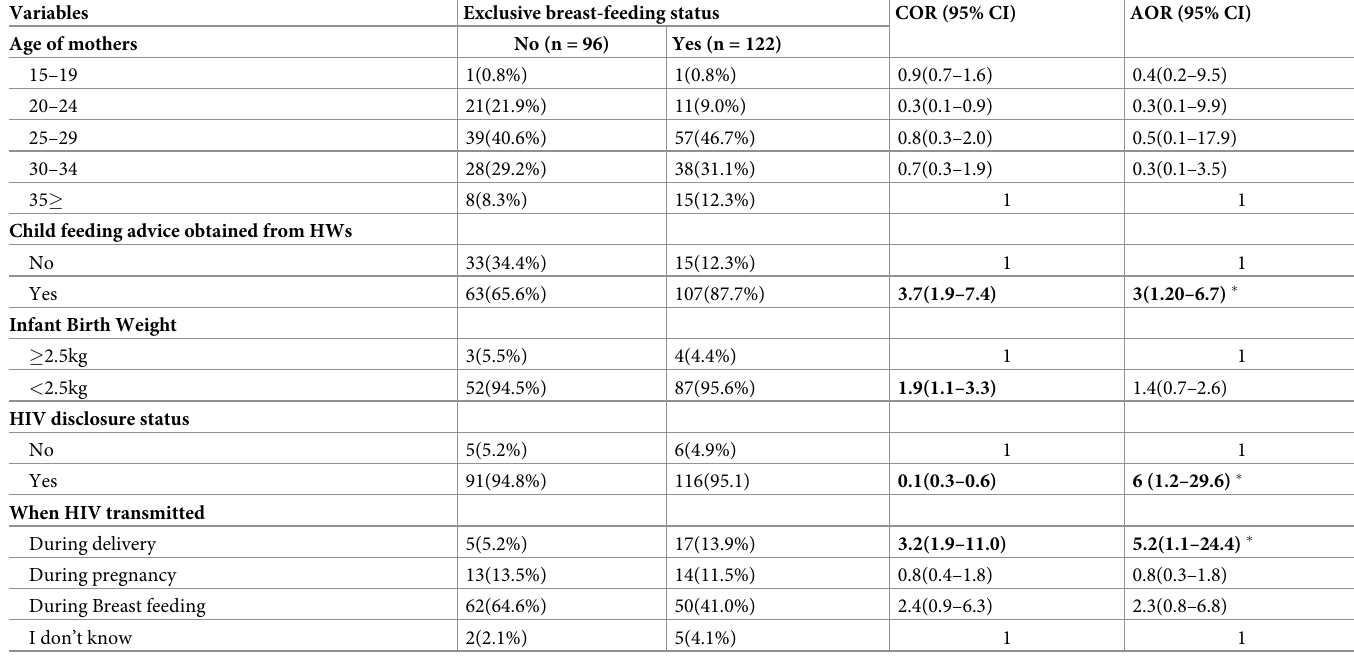
Table 4. Determinants of Exclusive Breast-feeding Adherence among HIV Positive Mothers in West, East and Kellem Health institutions, western Ethiopia, Sep- tember 2017 to June 30,